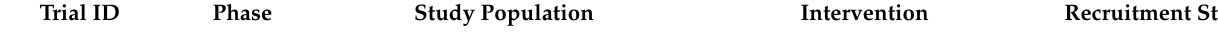
Table 1. Ongoing clinical trials evaluating the use of different modalities in metastatic colorectal cancer. Trial